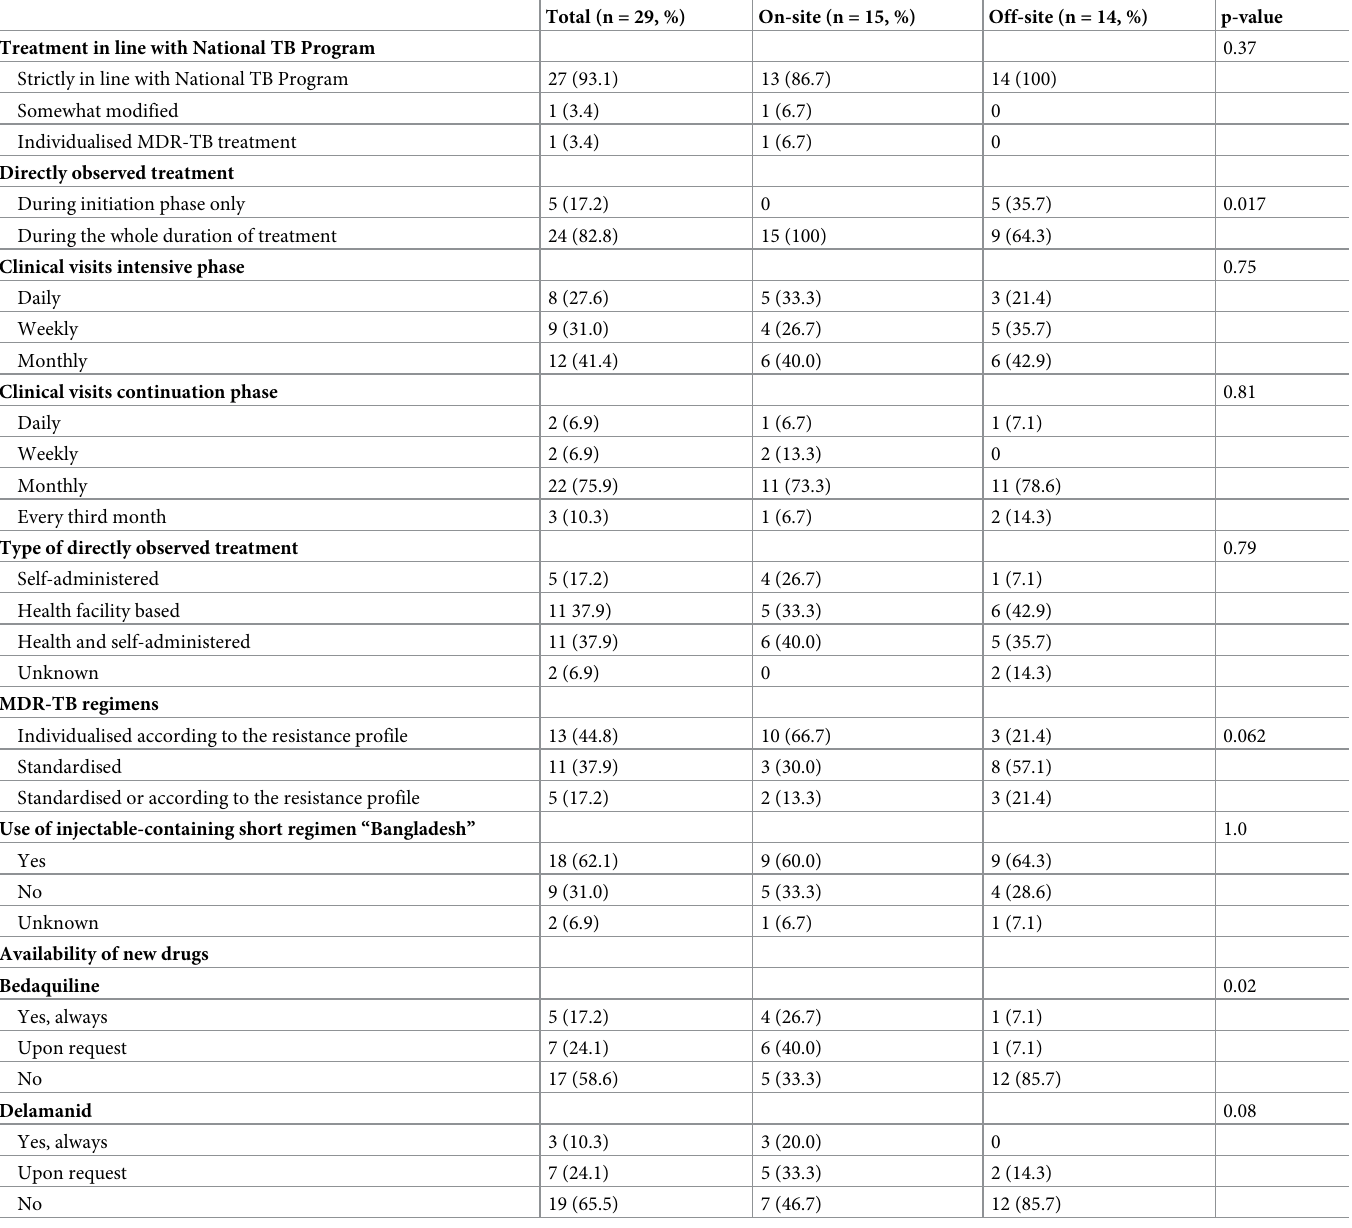
Table 2. Management and treatment of MDR-TB at 29 ART